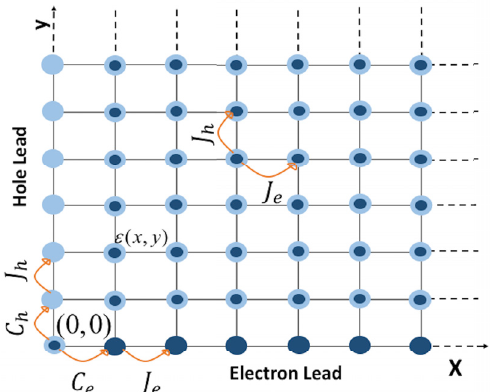
Fig. 2. The Hilbert space of the electron-hole pair by consid- ering just one evacuation channel for each charge carrier, with one state at each point ( x , y ) of the lattice. The coordinates x and y of a given state represent the position of electron and hole in their respective leads. ε ( x,y ) is the onsite energy of each site of the square lattice and the hopping integrals ( C and J ) are along the bonds of the square